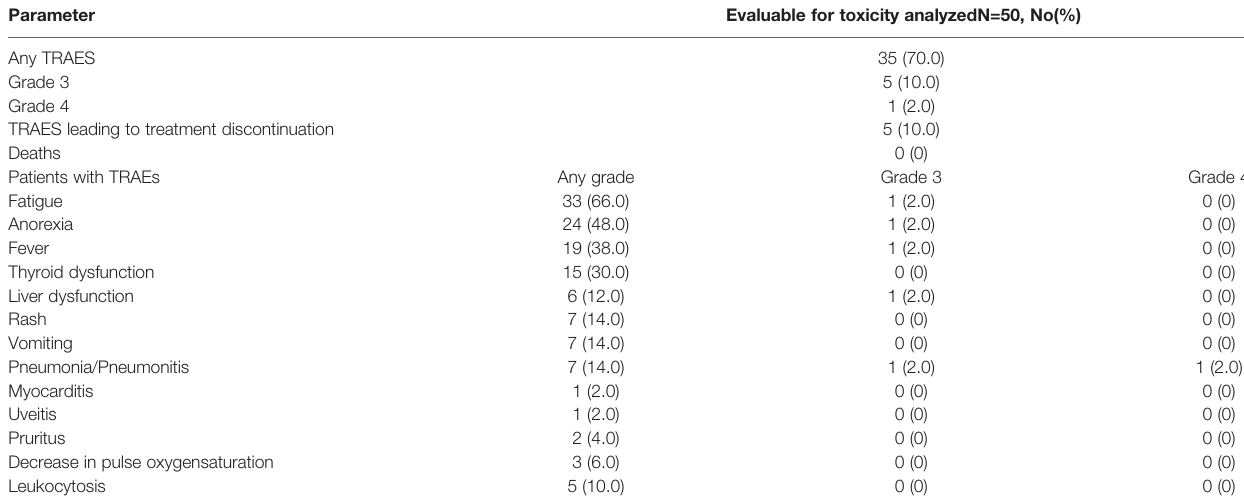
TABLE 2 | Treatment-related adverse events (TRAEs).